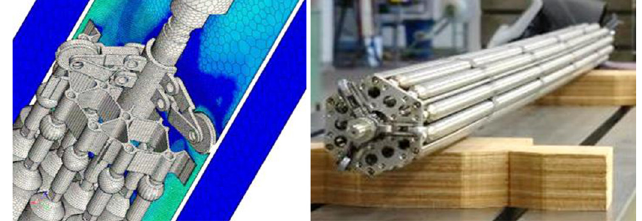
Fig. 1. MYRRHA control rod quali